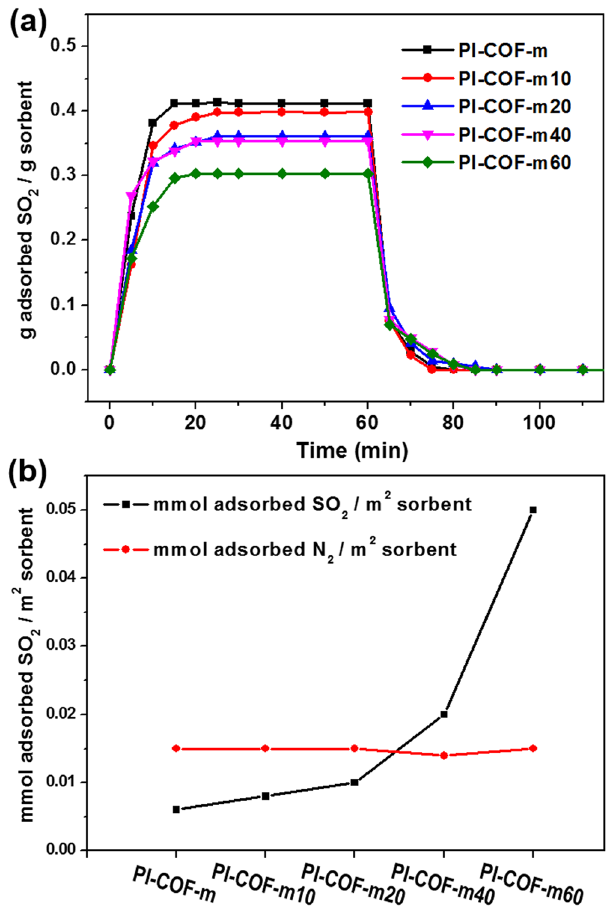
Figure 4. Sorption capacity of PI-COF-m X ( a ) A comparison of the SO 2 sorption and desorption of the PI - COF - m X series; here, SO 2 was adsorbed for 60 min at 25 °C at atmospheric pressure, then desorbed at 100 °C for 60 min under flowing N 2 at a rate of 30 mL/min; ( b ) the effect of surface area on the PI - COF - m X series for the SO 2 and N 2 sorption.